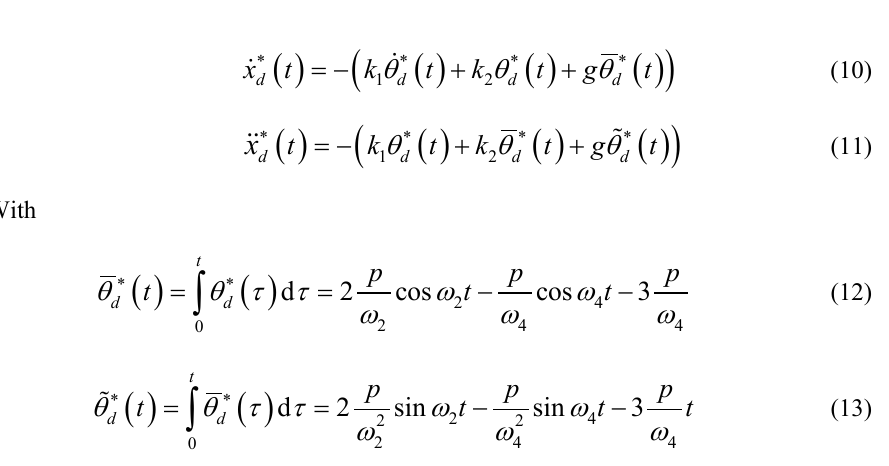
figure 2. Clearly in figure 2, the initial and terminal states meet the requirements in table